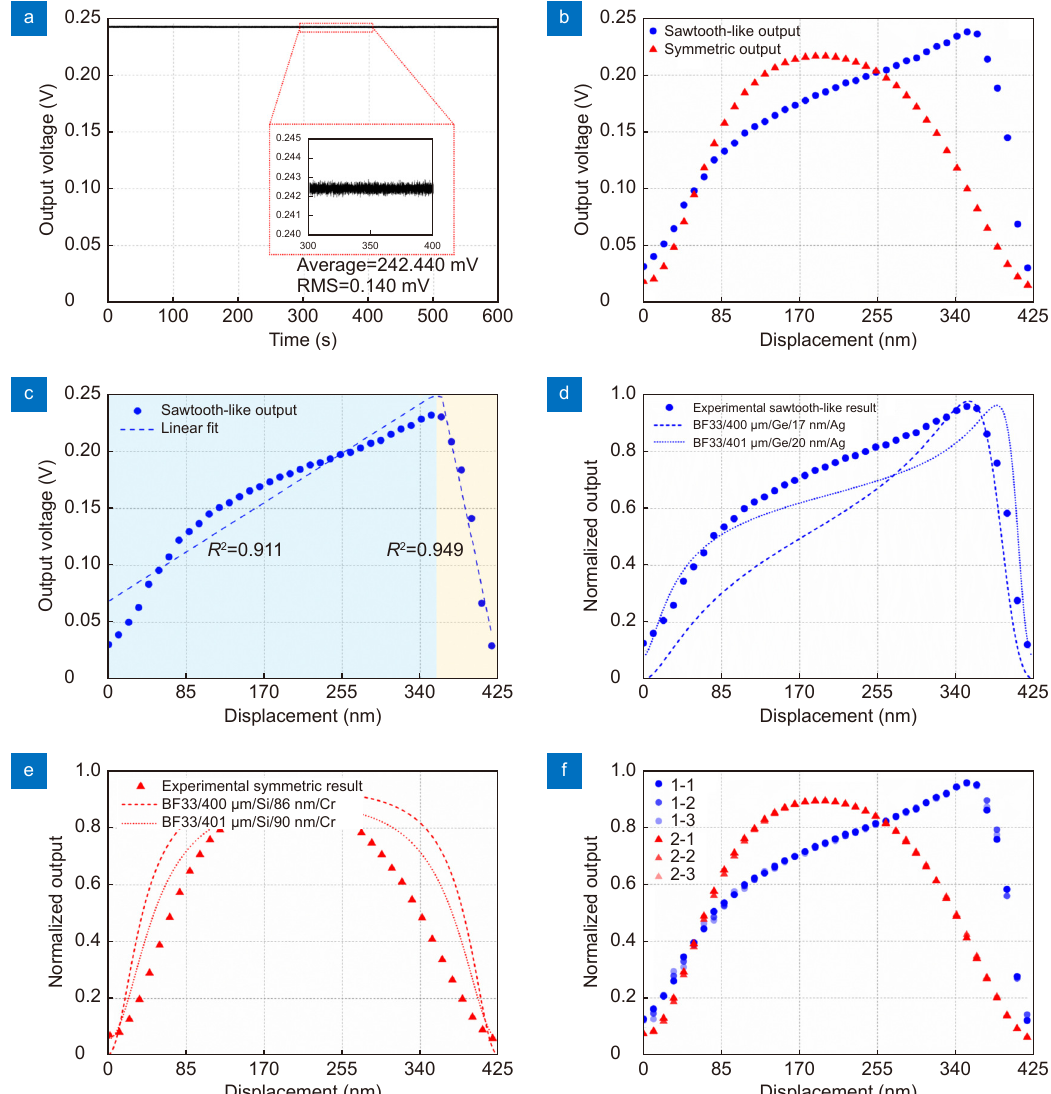
Fig. 8 | Experimental data. ( a ) Output voltage of the incident light as a function of time. ( b ) Static outputs of the optical cavities versus displace- ment for two designs, each point denotes an average value at a specific displacement. ( c ) Linear fit of the experimental result of the sawtooth-like design. ( d ) Comparison of the experimental results of the sawtooth-like design and theoretical results of optimal setting and setting considering tolerance. ( e ) Comparison of the experimental results of the symmetric design and theoretical results of optimal setting and setting considering tolerance. ( f ) Results of the repeatability test for two